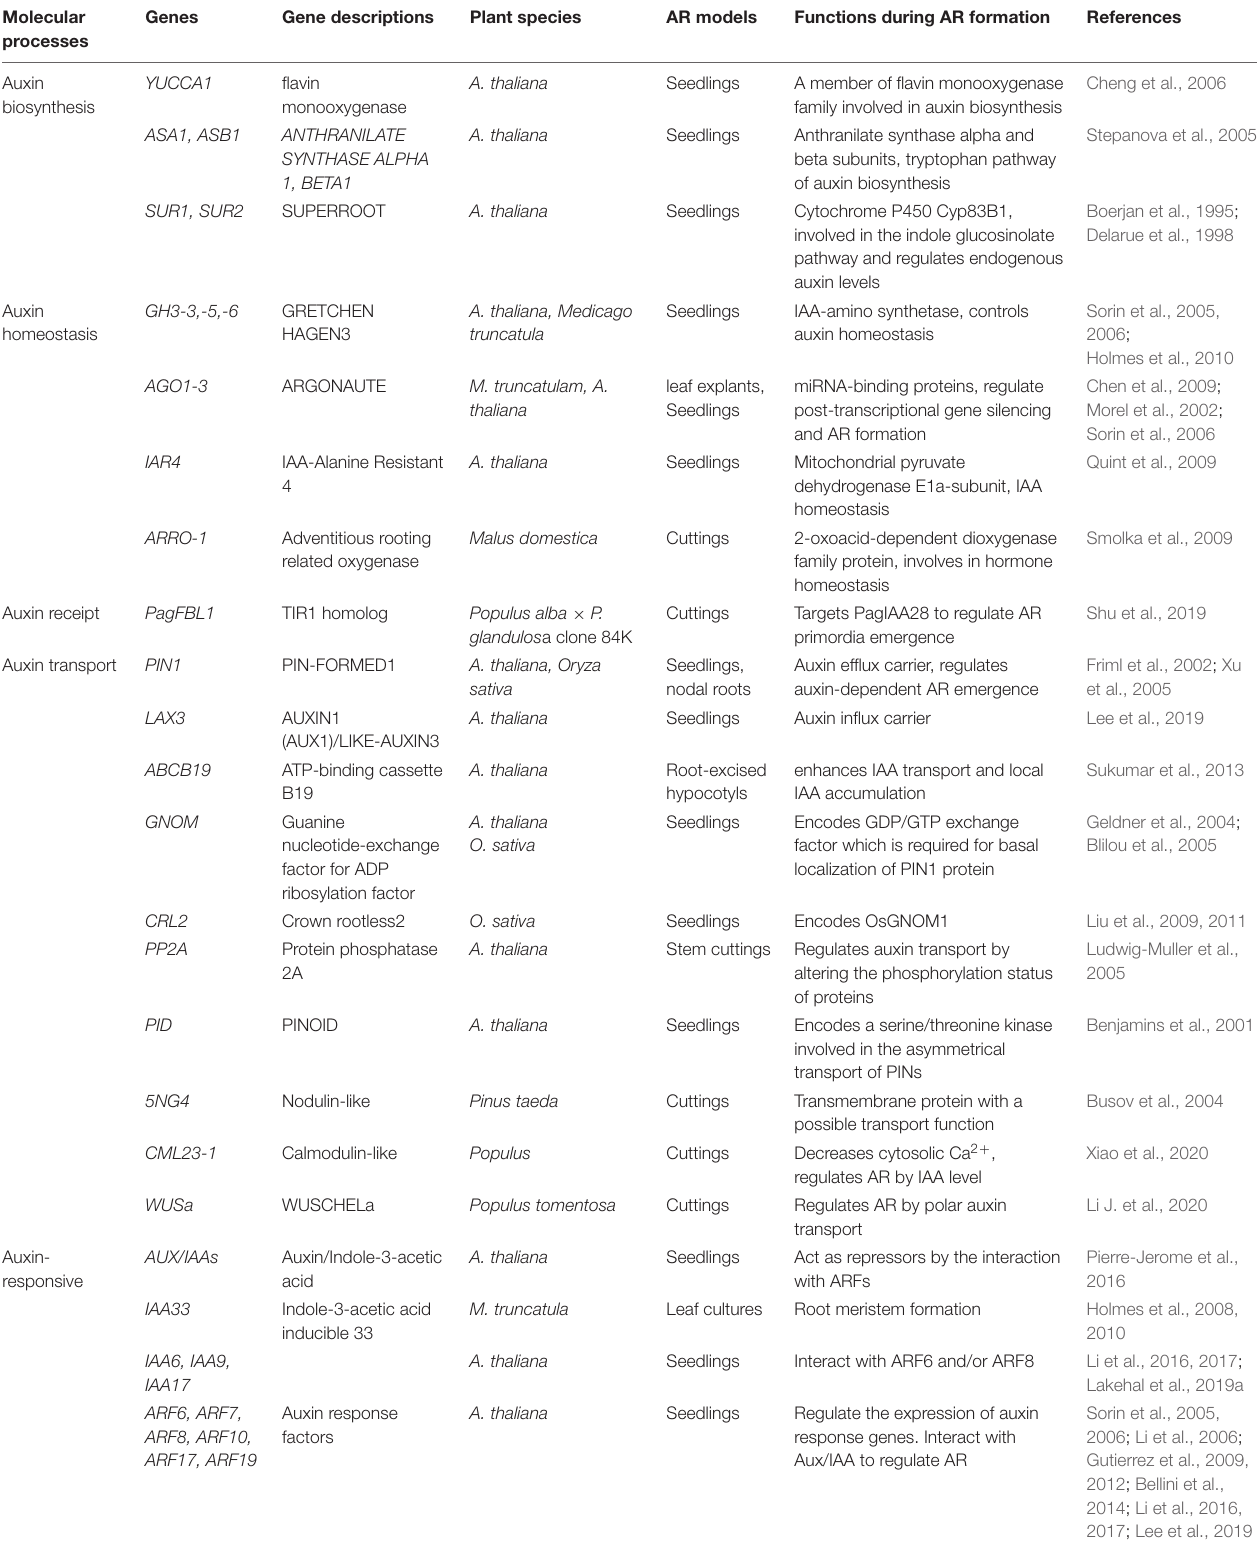
TABLE 1 | List of genes that have been identified to be involved in AR development. Molecular